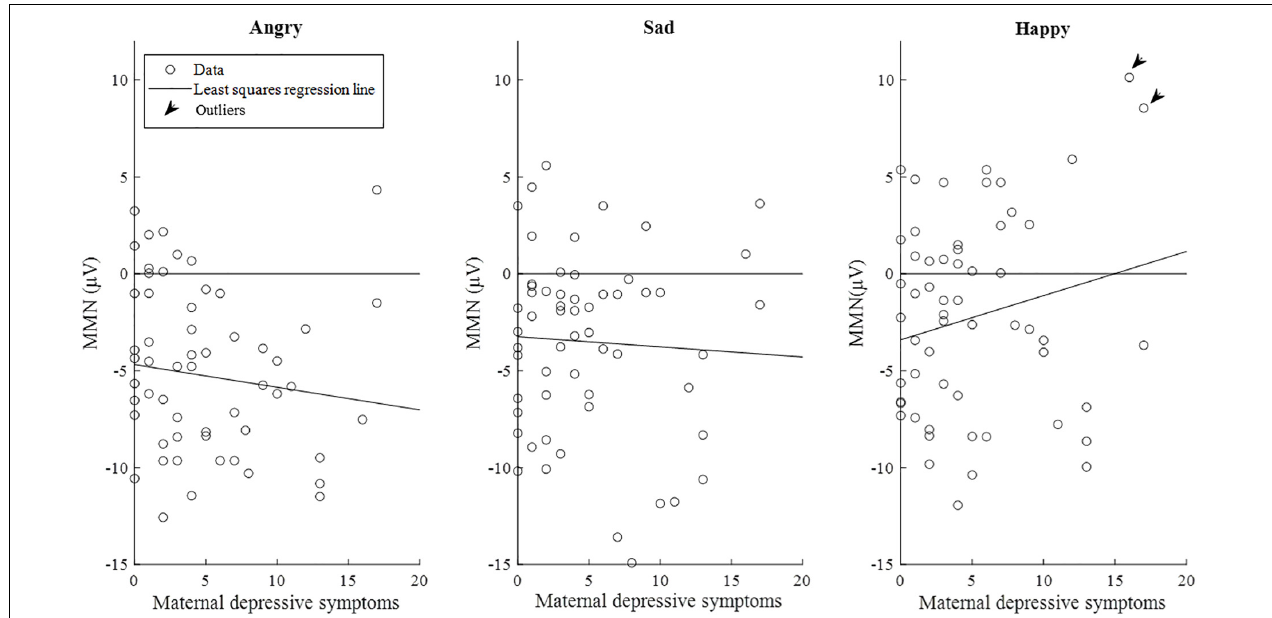
FIGURE 6 | Scatterplots of maternal depression symptoms and the mismatch response amplitudes ( µ V) of the children ( n = 58) in the late time window (350–450 ms). Of note, the lines are least-squares regression lines fitted across the data points, not the results of the mixed-effects models. Outliers = subjects with the mismatch response amplitude exceeding the value of 7 µ V in the emotion category “Happy” ( N =